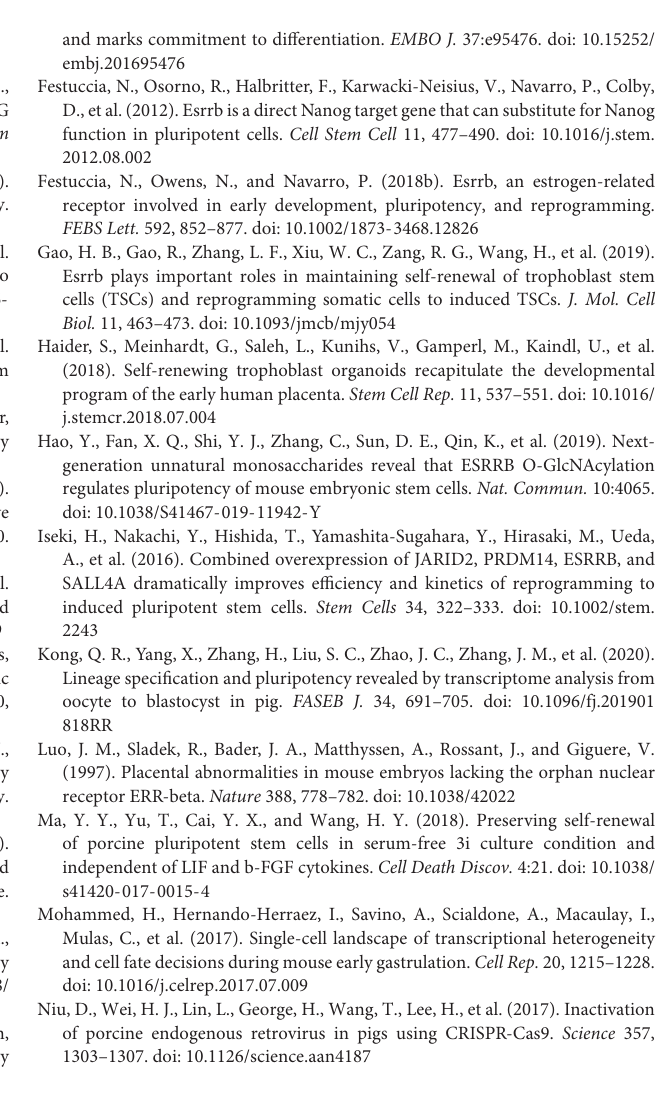
Supplementary Figure 4 | The effect of DOX on ESRRB piPSCs. (A) Western blot analysis of FLAG in the ESRRB-WT, N-terminus and C-terminus domain cell lines; (B) the phenotype of ESRRB-piPSCs after using different doses of DOX; (C) ESRRB-interacting proteins were visualized by Coomassie brilliant blue staining. Supplementary Figure 5 | The combined analysis of the RNA-seq and ChIP-seq of ESRRB. (A) Distribution of ESRRB-FLAG ChIP-seq signal on both sides